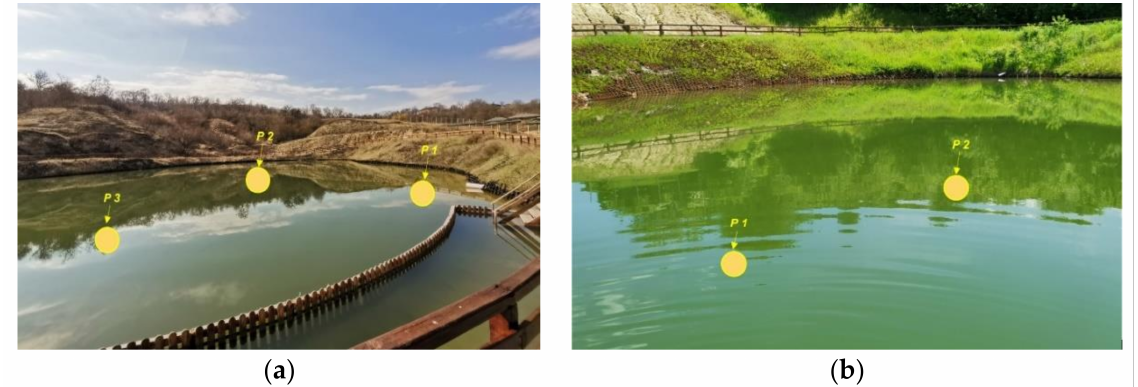
Figure 2. Sampling points for Lake Ocnei ( a ) and Lake Rotund ( b ) in